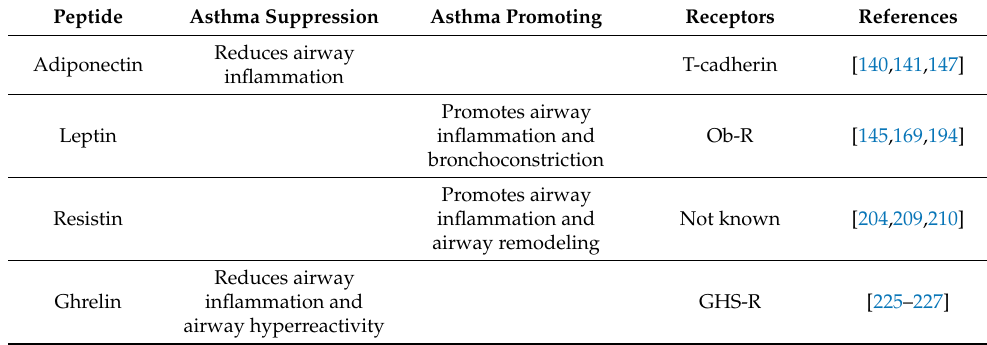
Table 4. Obesity-related peptides involved in mediating asthma symptoms. A description of the action of a particular peptide and the receptors through which it